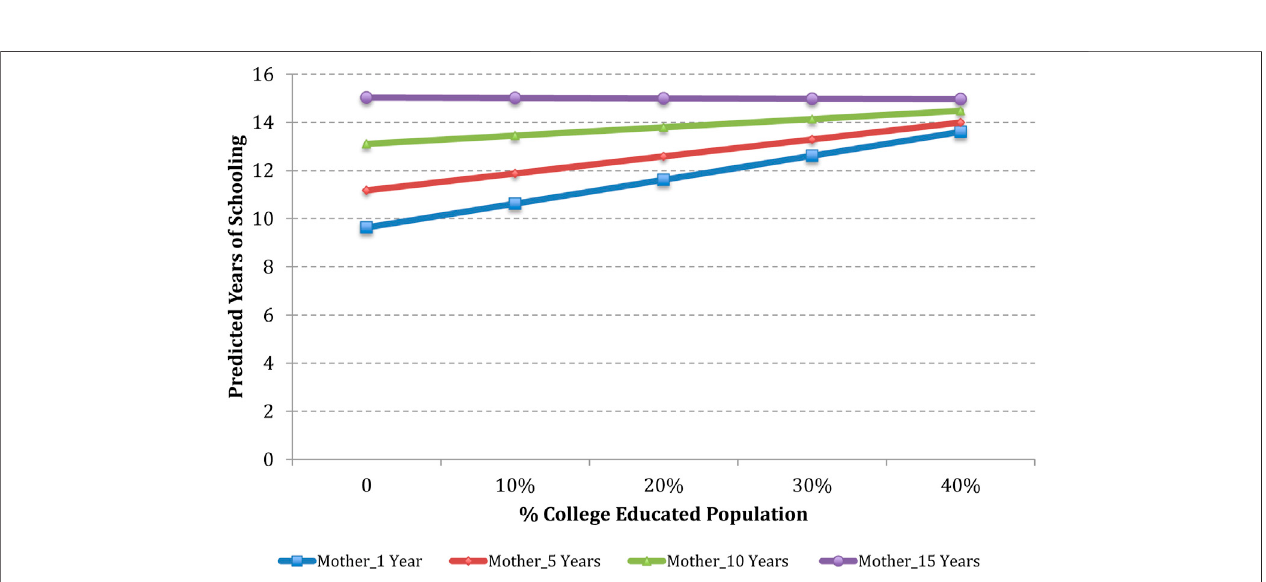
FIGURE 3 | Predicted years of schooling of 2nd generation Hispanic men as a function of the level of mother ’ s schooling and percentage of the college-educated population in the county.